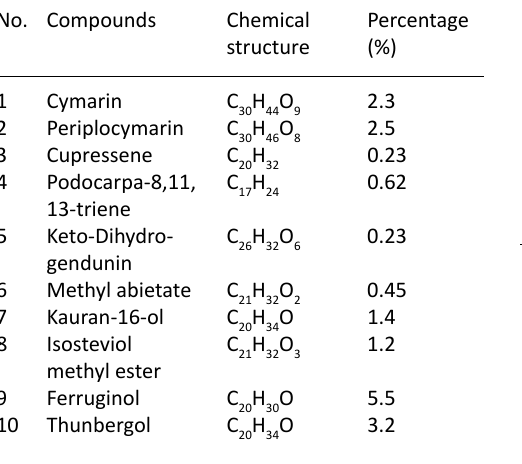
Table 1. GC-MS analysis of ethyl acetate fraction of fruit of Platycladus orientalis